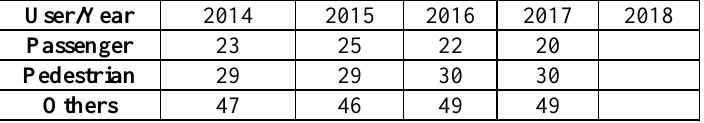
Figure 11: Variation of accidents over the last ten years. Table 20: Percentage of deaths by road user category.